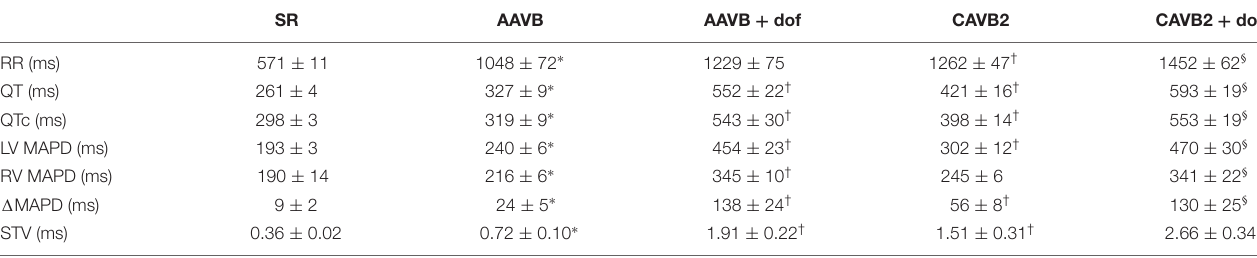
TABLE 1 | Electrophysiological